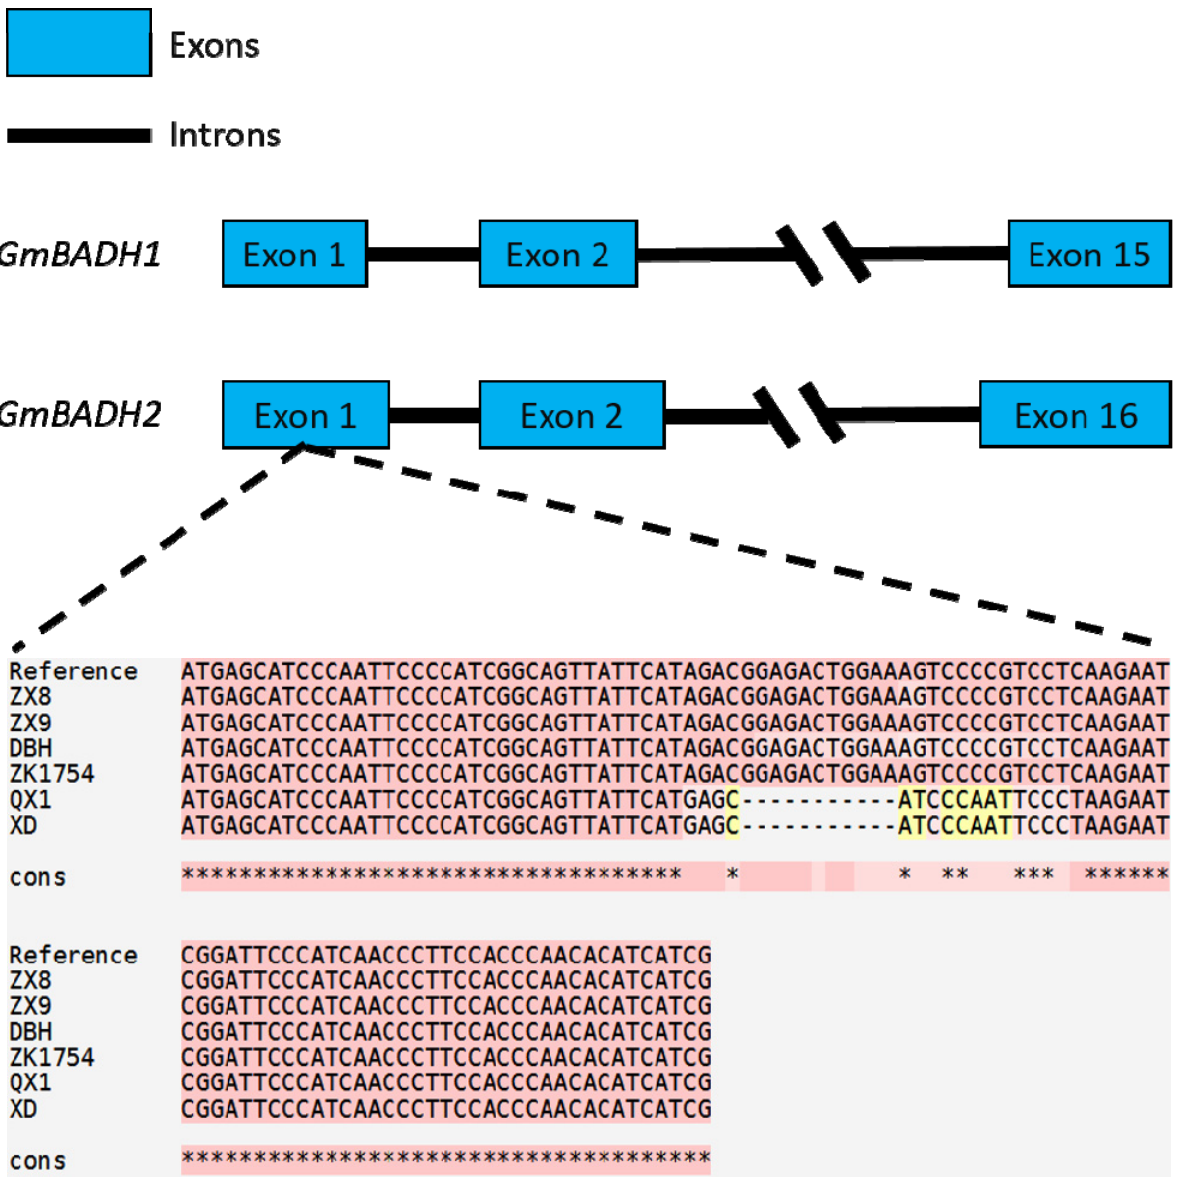
Figure 1. Alignment of part of the GmBADH2 sequence (exon 1) in aromatic and non-aromatic soybean varieties. There were 10 SNPs and an 11-nucleotide deletion in exon 1 of GmBADH2 in two aromatic soybean varieties. Aromatic soybean varieties: ZK1754, QX1, and XD; non-aromatic soybean varieties: ZX8, ZX9, and DBH; reference: Williams 82.